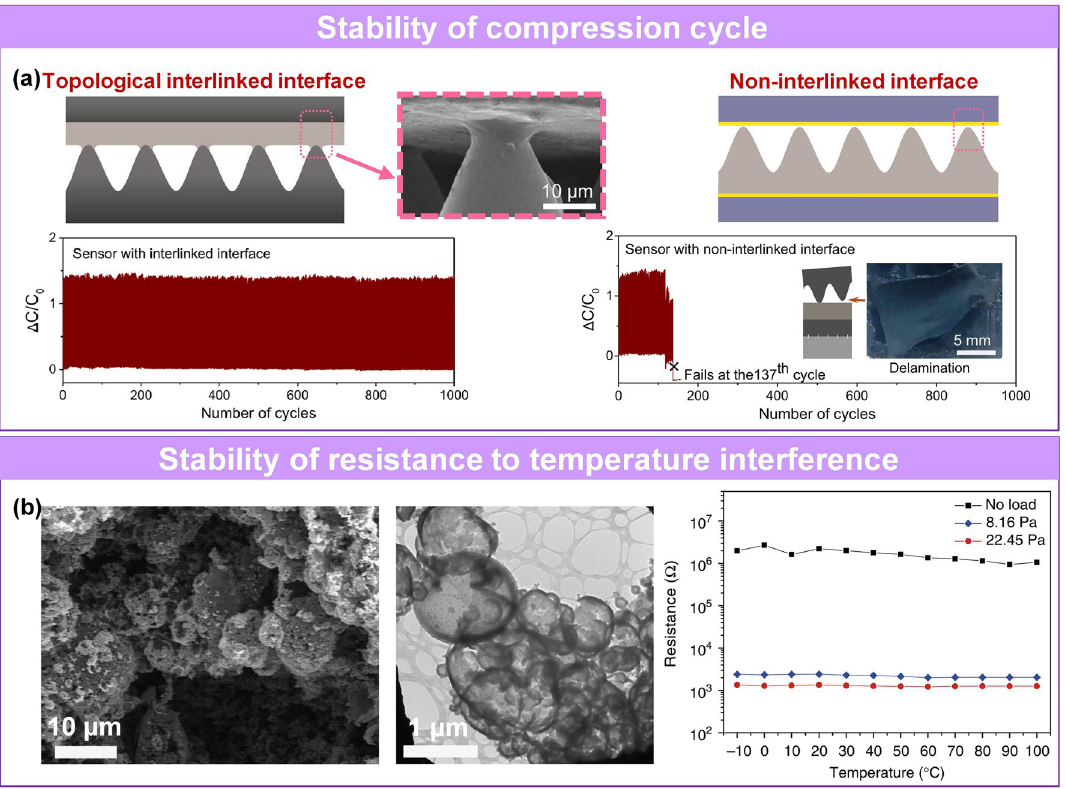
Fig. 9 Pressure sensors with stable response. a Comparison of stable cycle performance of that with strong linked-interface and that with unin- terlinked-interface [81]. Copyright (2022) The Authors. b Stable anti-temperature interference ability caused by hollow structure [82]. Copyright (2014) Springer